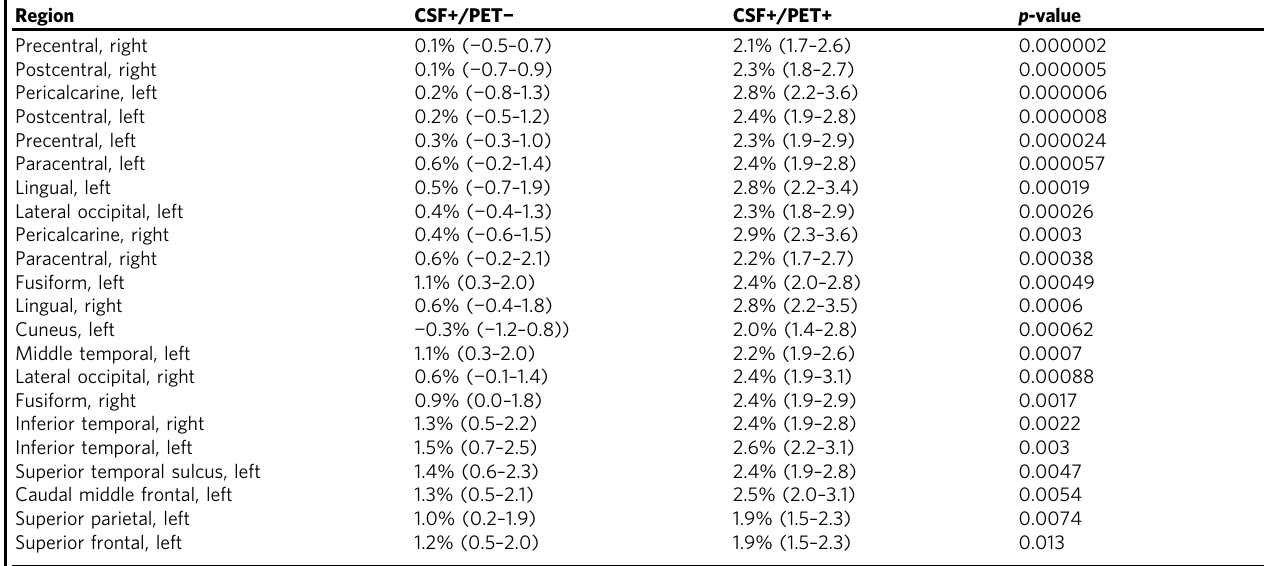
Table 3 Annual A β accumulation rates in the signi fi cant late A β regions in ADNI Region Precentral, right